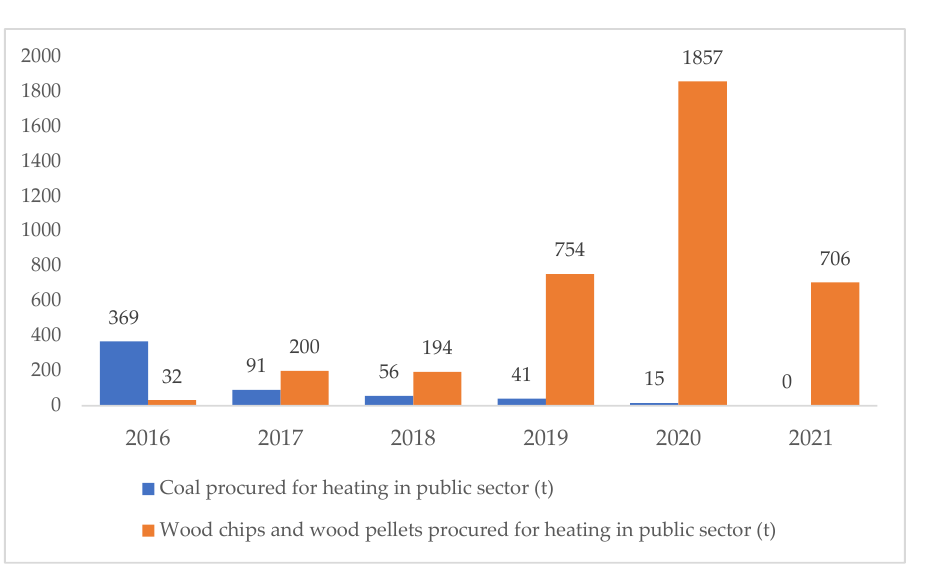
Figure 8. Procurement of selected fuels for the heating of public buildings in the municipality of Priboj [162].